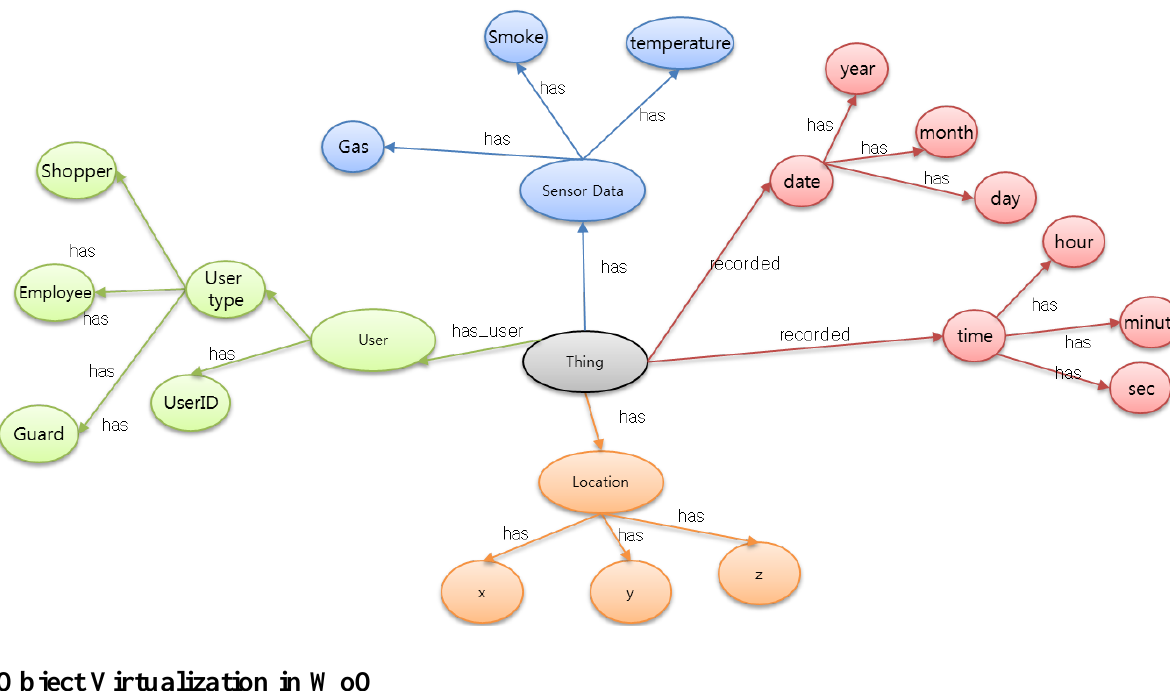
Figure 3. All the required objects to handle a fire emergency situation is considered in this figure. Virtual representation of all objects maintains the semantic relation with each other. For better visualization, all the objects are shown with arc but any kind of combination is possible based on the application